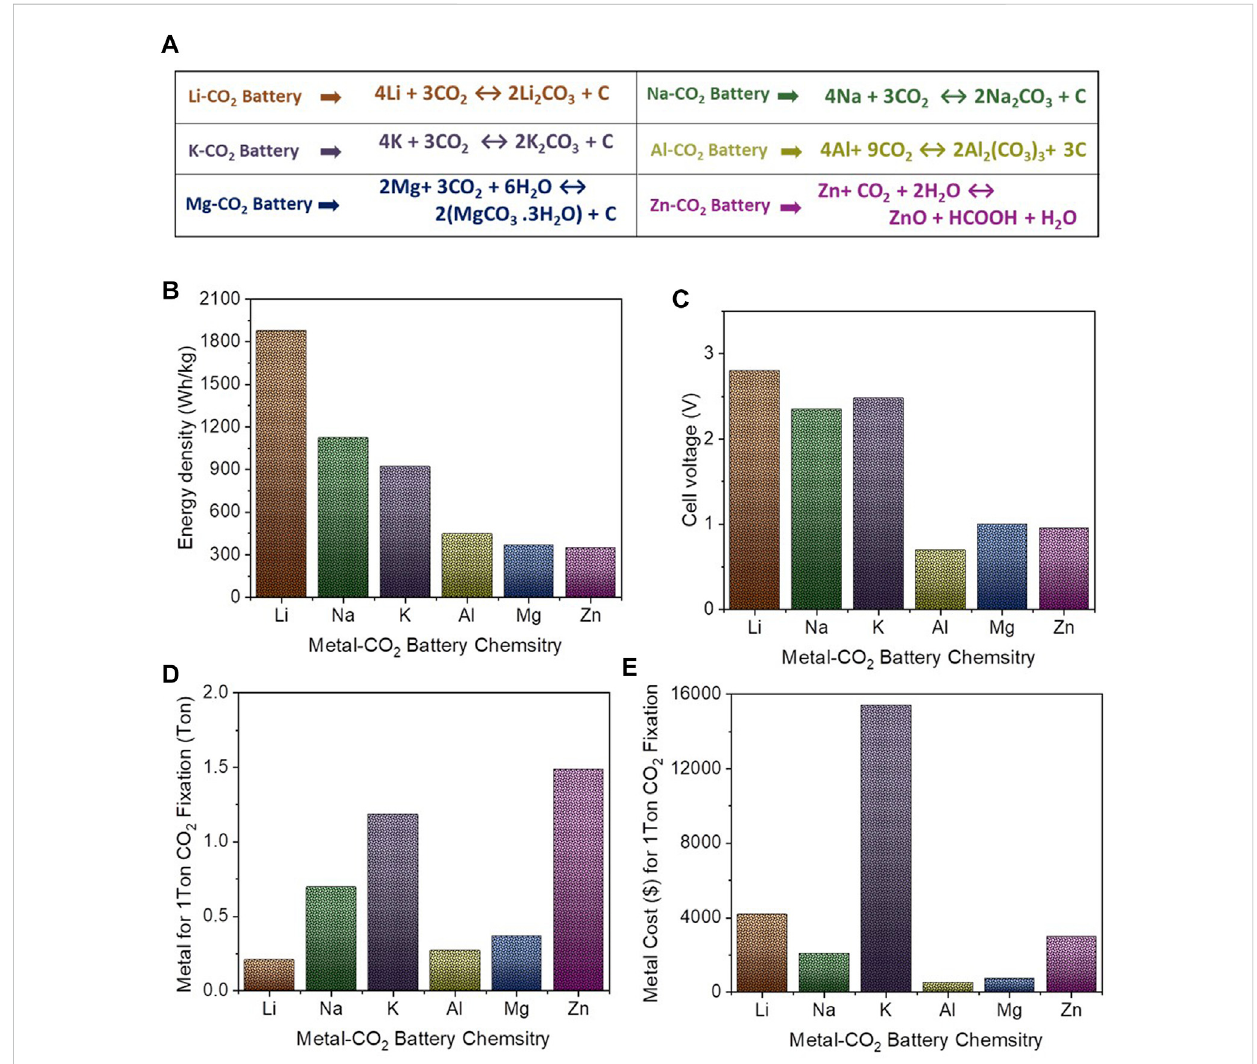
FIGURE 2 (A) . Thermodynamic reaction of Li-CO 2 (Sun X. et al., 2021),Na-CO 2 (Hu et al., 2017b), K-CO 2 (Zhang W. etal., 2020), Al-CO 2 (Ma et al., 2018a), Mg-